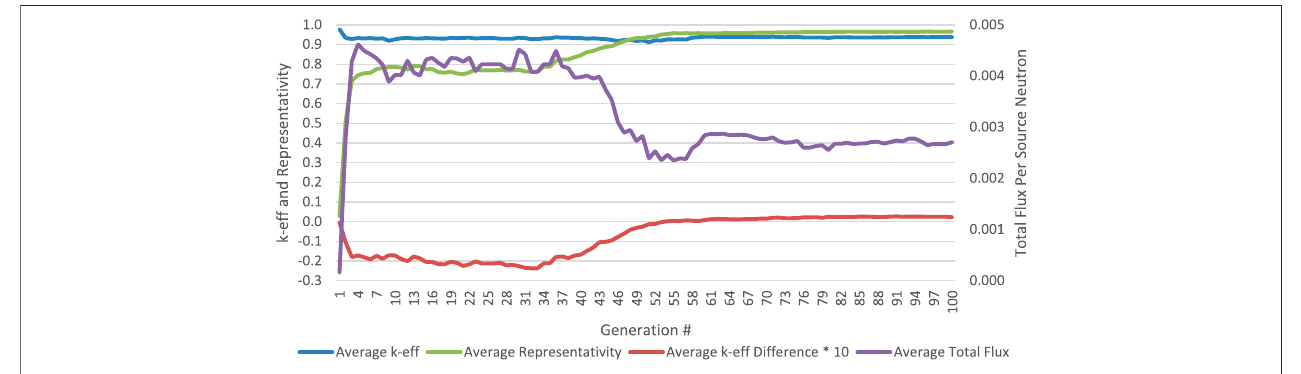
FIGURE 4 | Average parent objective function and constraint evaluation during NSGA-II optimization.